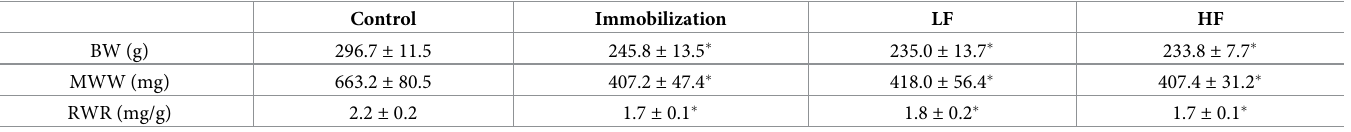
Table 2. Body weight, muscle wet weight, and relative weight ratio at 2 weeks.